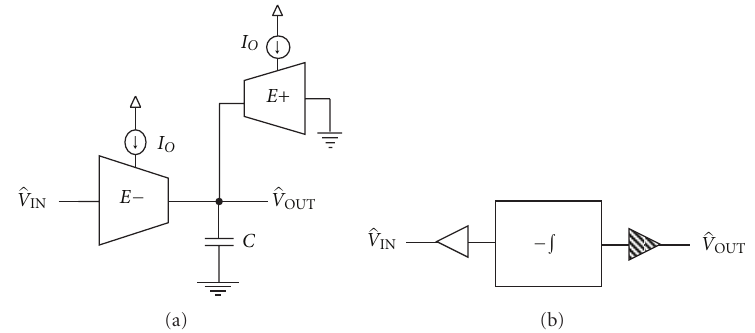
Figure 4: (a) Lossless DC stabilized log-domain inverting integrator. (b) The employed